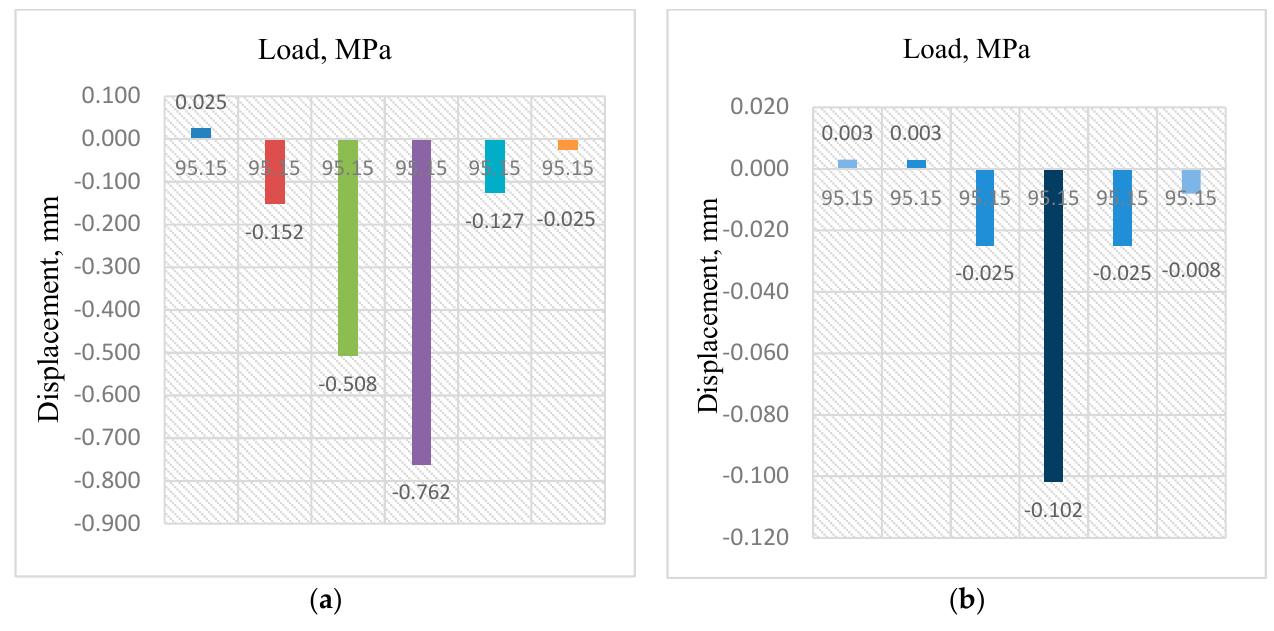
Figure 4. Load versus displacement. ( a ) Tire#1; and ( b ) tire#2.